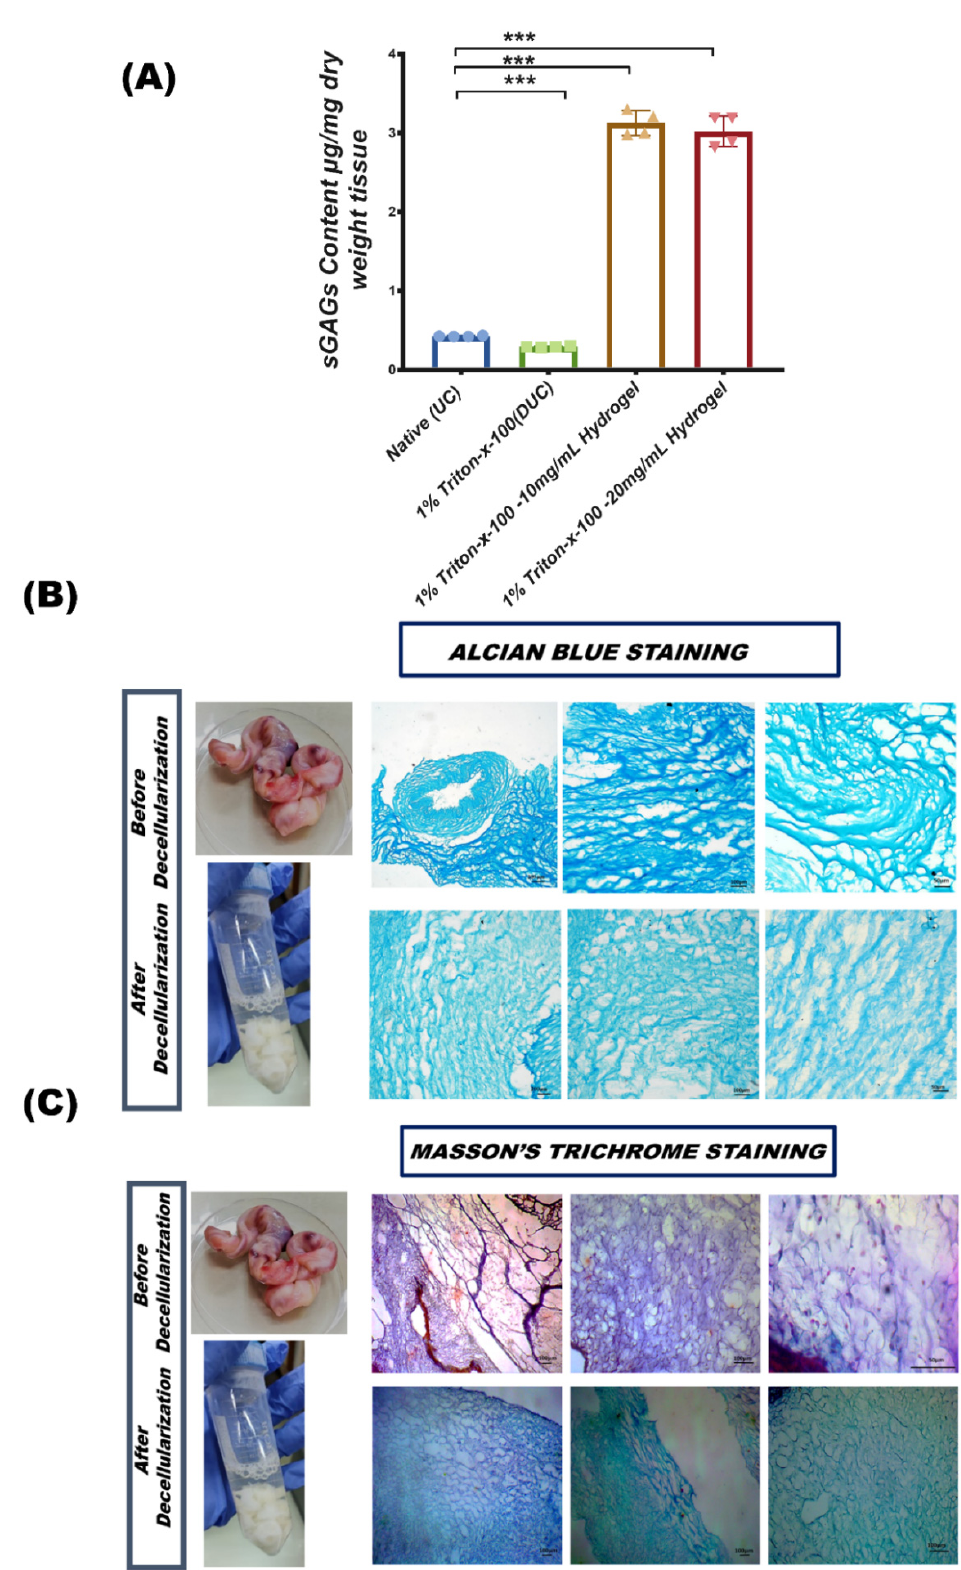
Figure 3. Quantitative and qualitative analysis of extracellular matrix. ( A ) sGAGs quantification by DMMB assay. ( B ) Alcian blue staining revealed the retention of sGAGs in the ECM of DUC ( n = 3, per study group, *** p < 0.001): GAGs are light blue. ( C ) Masson’s trichrome staining showed collagen fiber images of native and DUC tissue.